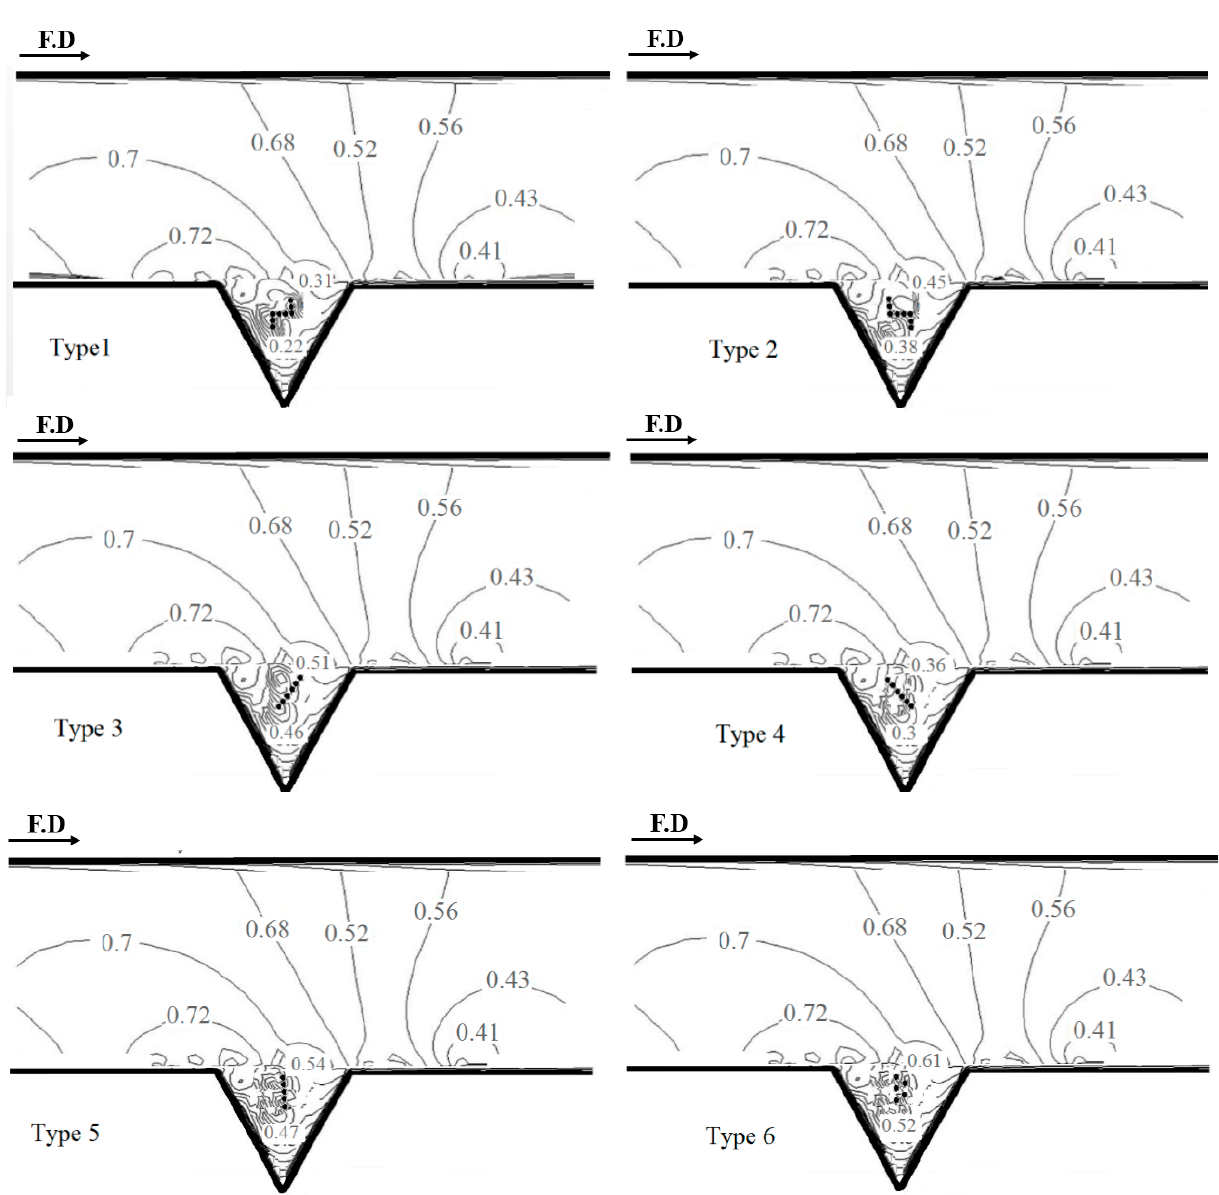
Figure 13. Longitudinal velocity contours in the main channel and around the antivortex structure.